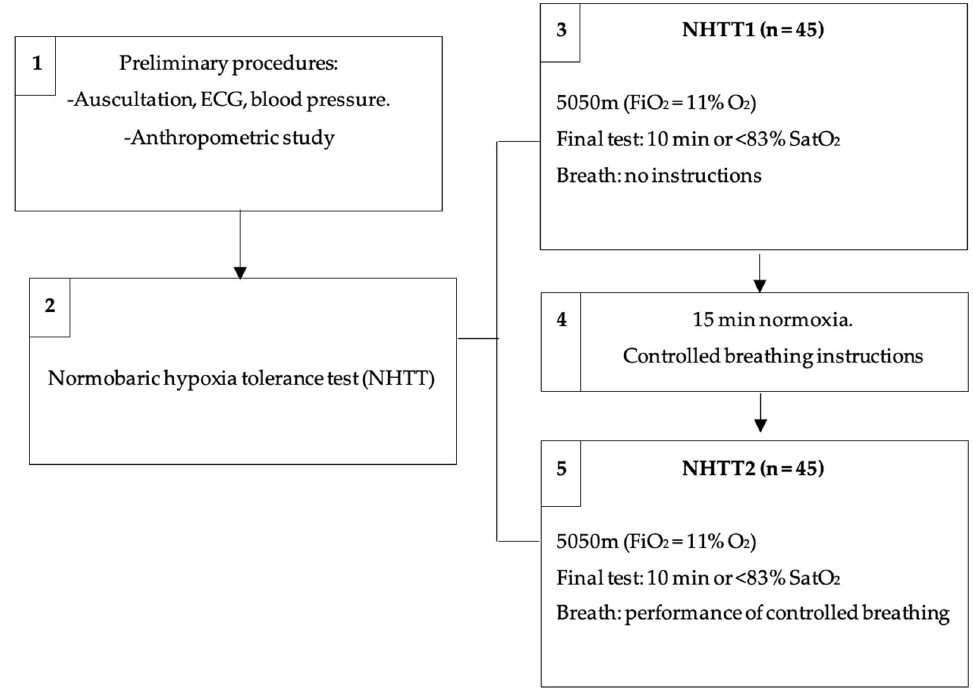
Figure 3. Outline of the phases of the investigation . ECG: electrocardiogram; NHTT: normo ‐ baric hypoxia tolerance test; FiO 2 : inspired oxygen fraction; NHTT1: first normobaric hypoxia tolerance test; NHTT2: second normobaric hypoxia tolerance test; SatO 2 : arterial oxygen saturation.